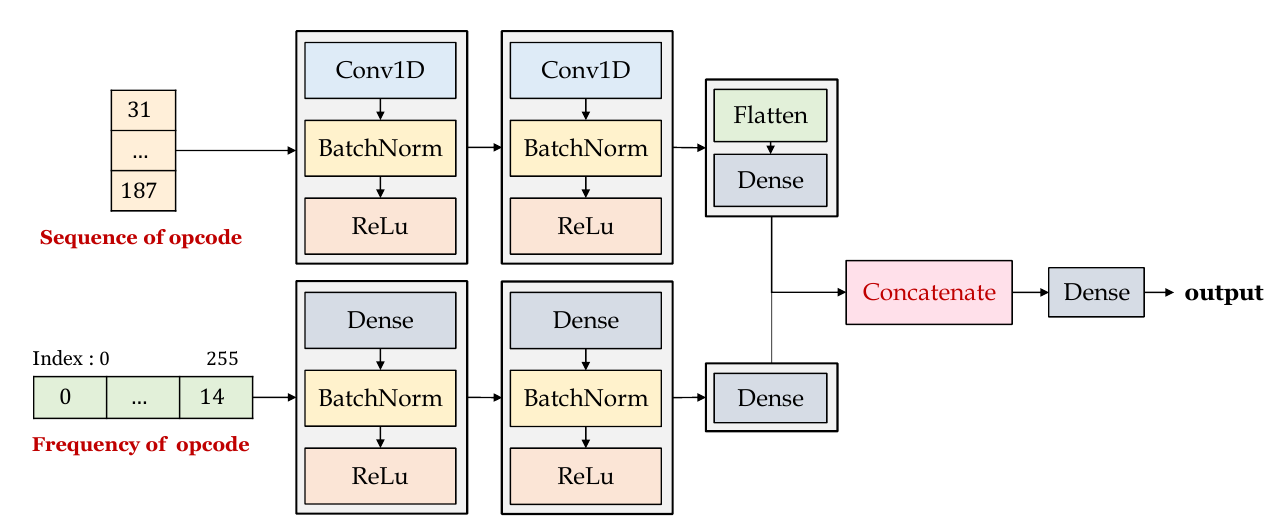
Figure 4. Neural network architecture for proposed method.